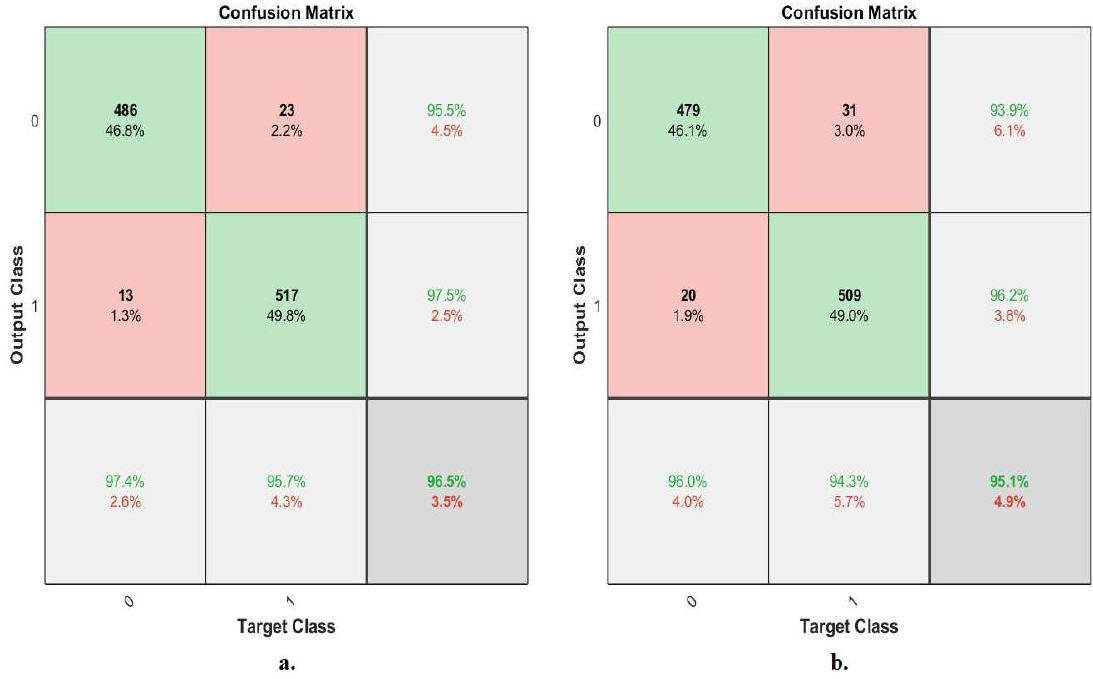
Figure 15. Confusion matrix for OSCC data set diagnosis by ANN based on deep features of models. ( a ) AlexNet; ( b )